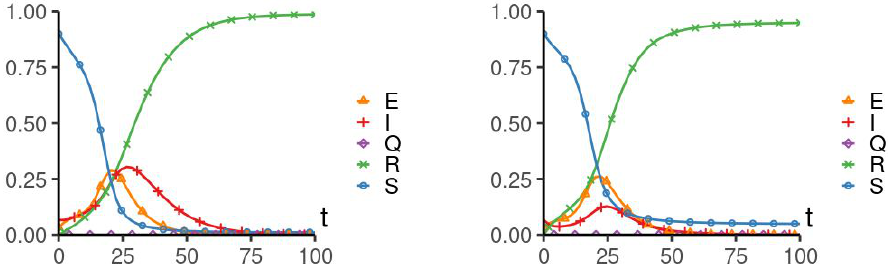
Figure 9. Experiment 1. Sum of the fractions of all levels: uncontrolled ( left ) and controlled cases ( right ).